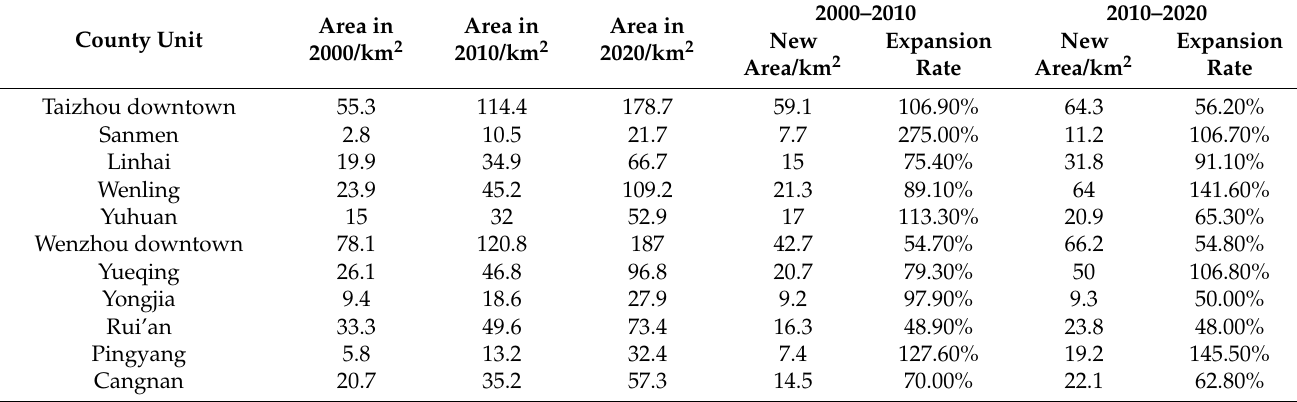
Table 3. Statistical description of PUAs in different